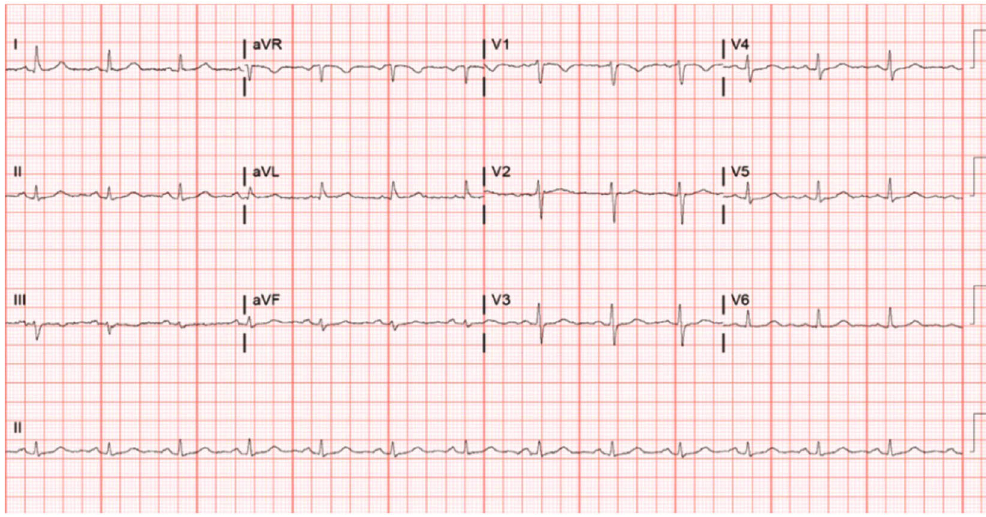
Figure 3: ECG demonstrating sinus